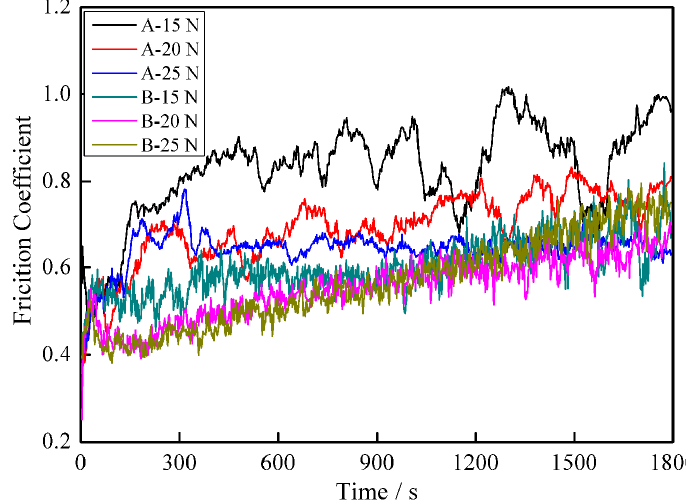
Figure 6. The change of friction coefficient of coatings A and B with time under different loads.